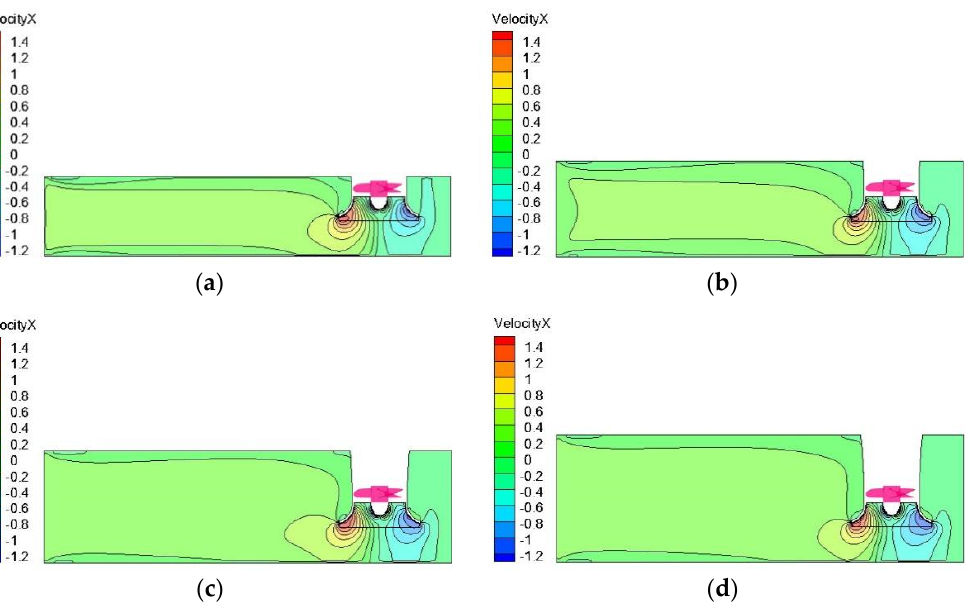
Figure 7. Velocity distribution of section 1-1 for different top floor height. ( a ) Case 1, ( b ) Case 2, ( c ) Case 3 and ( d ) Case 4.